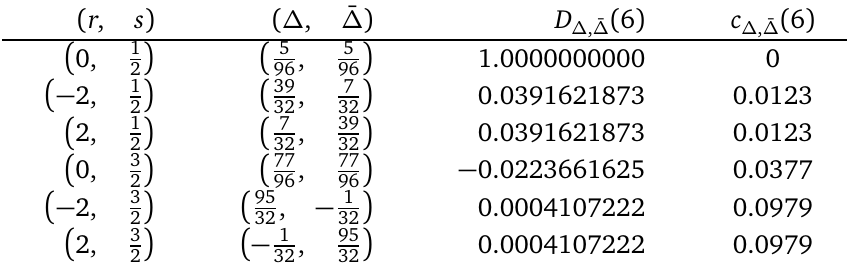
Table 8: Truncating the spectrum (cid:83)